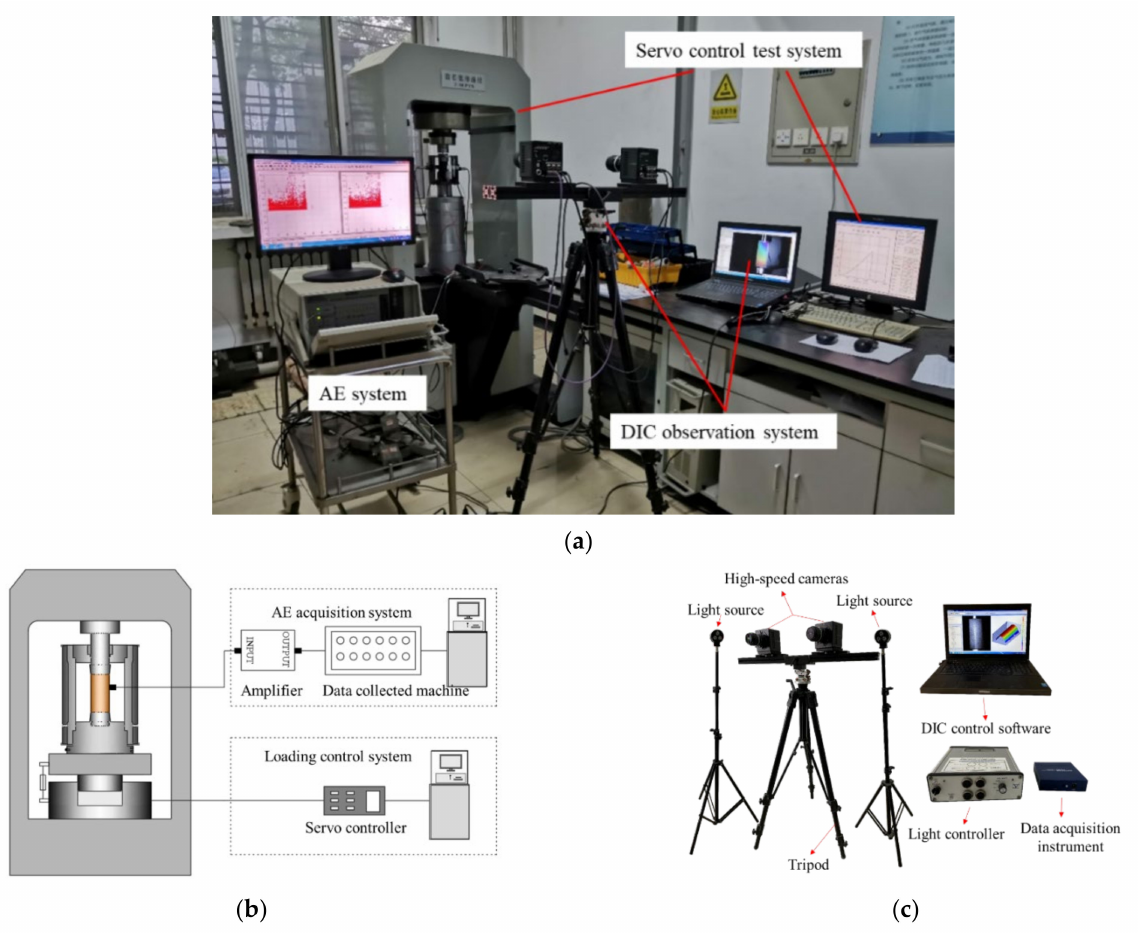
Figure 2. The experimental apparatus: ( a ) full view; ( b ) AE system and loading cell; ( c ) 3D-DIC observation system. Table 1. Experiment